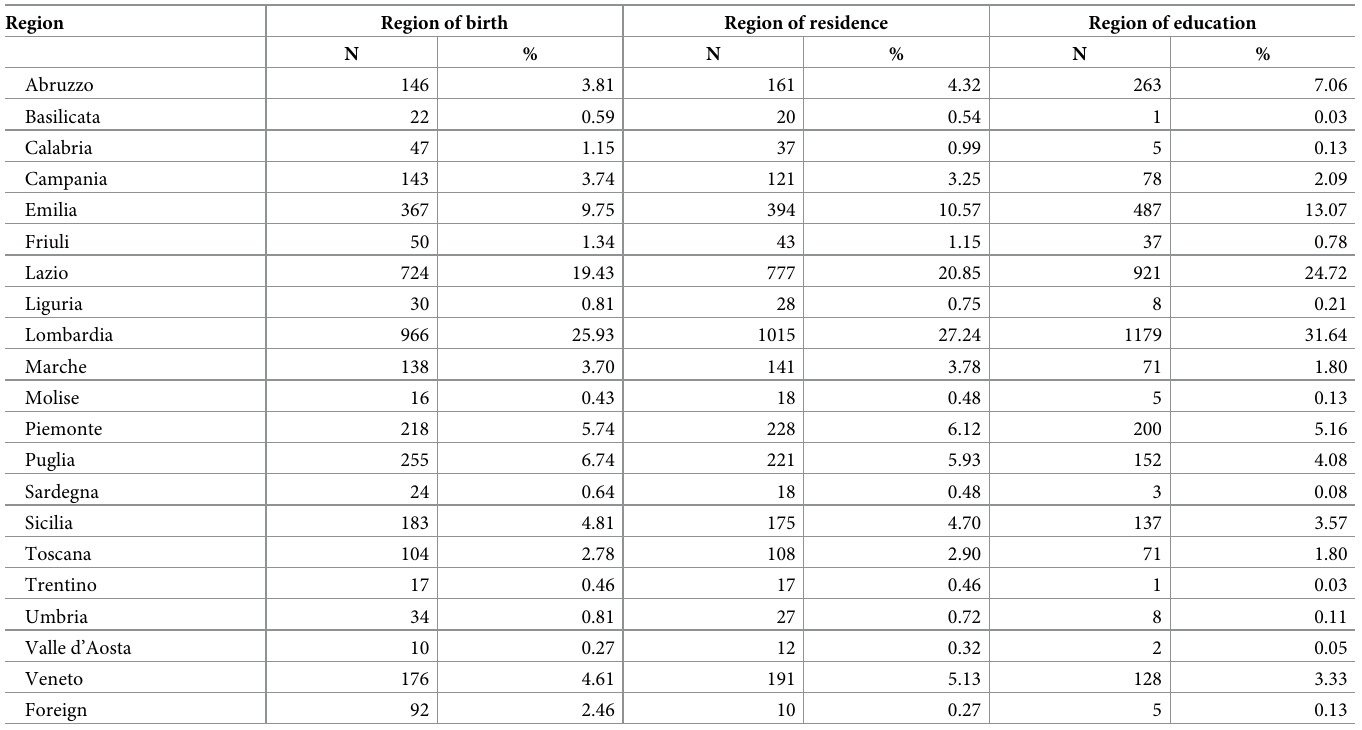
(Table 4). Noticeably, 244 students, accounting for 6.5% of the participants, declared to suffer from “other” health